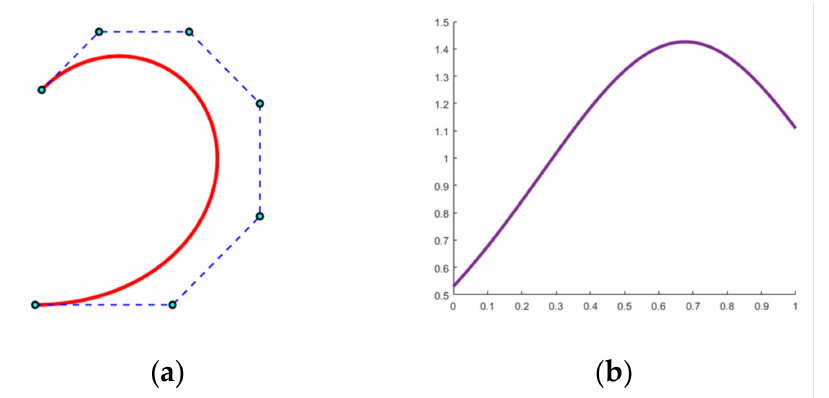
Figure 5. A typical B é zier curve with k = 5 when s > cos θ (0 < s < 1). ( a ) s = 0.9, θ = π /4 and ∆ b = [ 1,0 ] T ; ( b ) curvature plot. 0